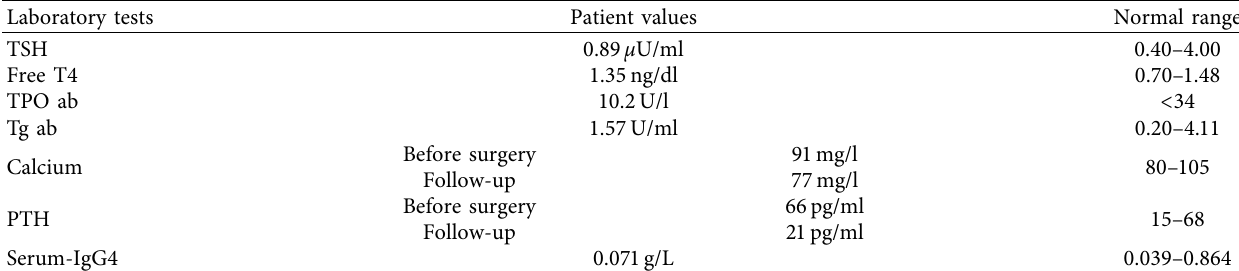
Table 1: Patient’s laboratory results.